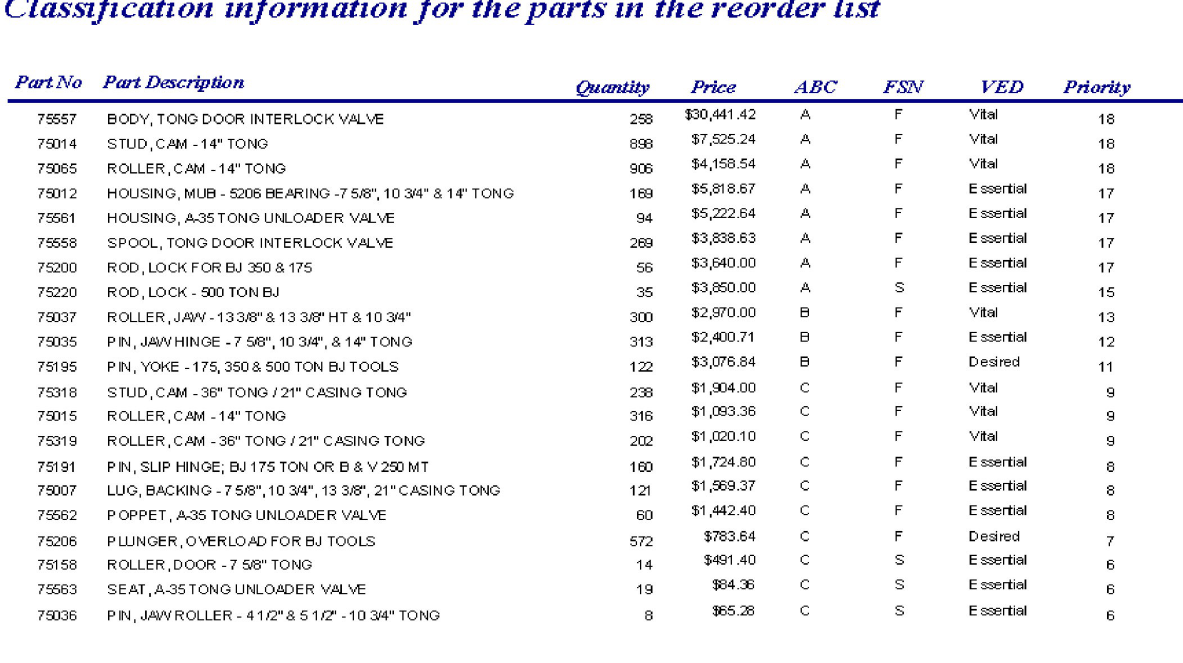
Figure 3. Sample output